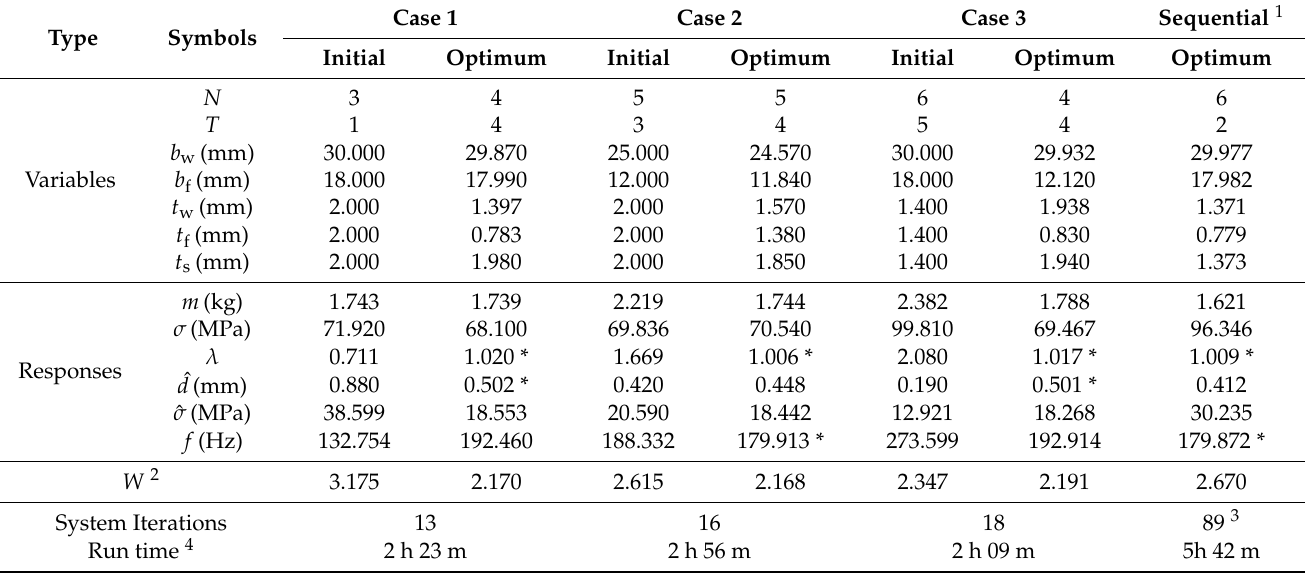
Table 5. Optimization results.